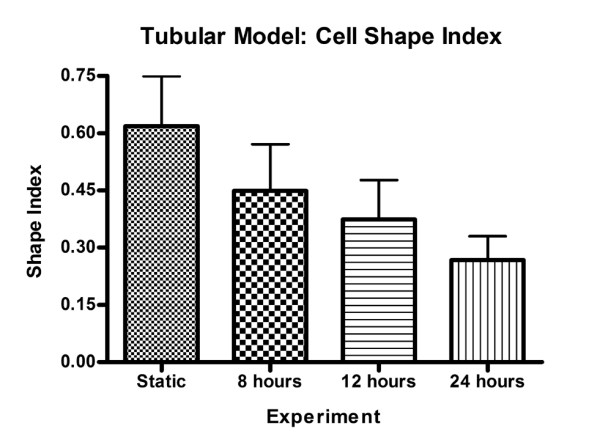
Cell shape index time history for tubular model experiments, static, 8 hrs, 12 hrs and 24 hrs; SI = 1 corresponds to a perfect circle, while SI = 0 corresponds to a line; all values are expressed as mean ± standard deviation (n = 791, 562, 508, 276 respectively).